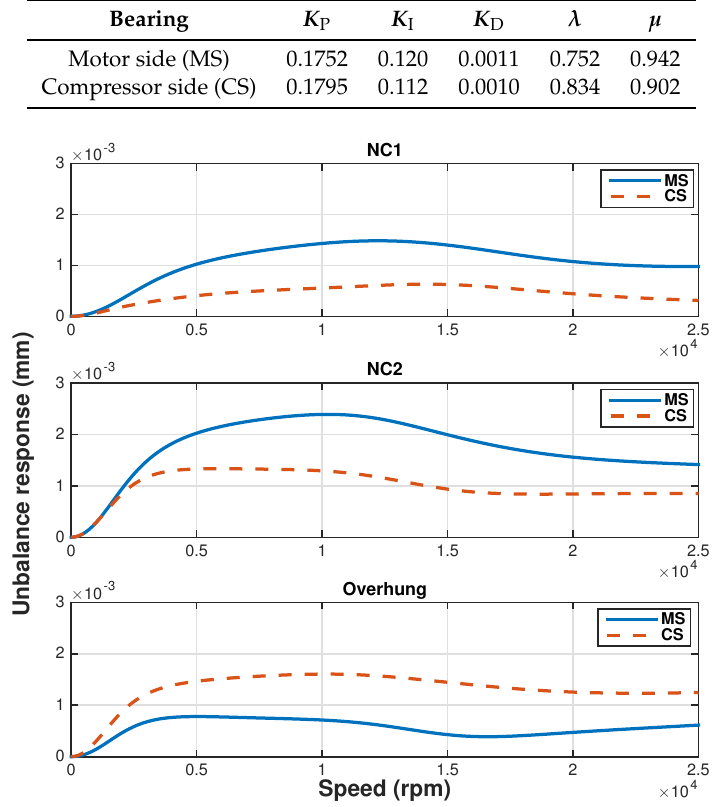
Figure 20. Forced response with unbalance mass placing for three excitation cases as specified in API 617 [22].